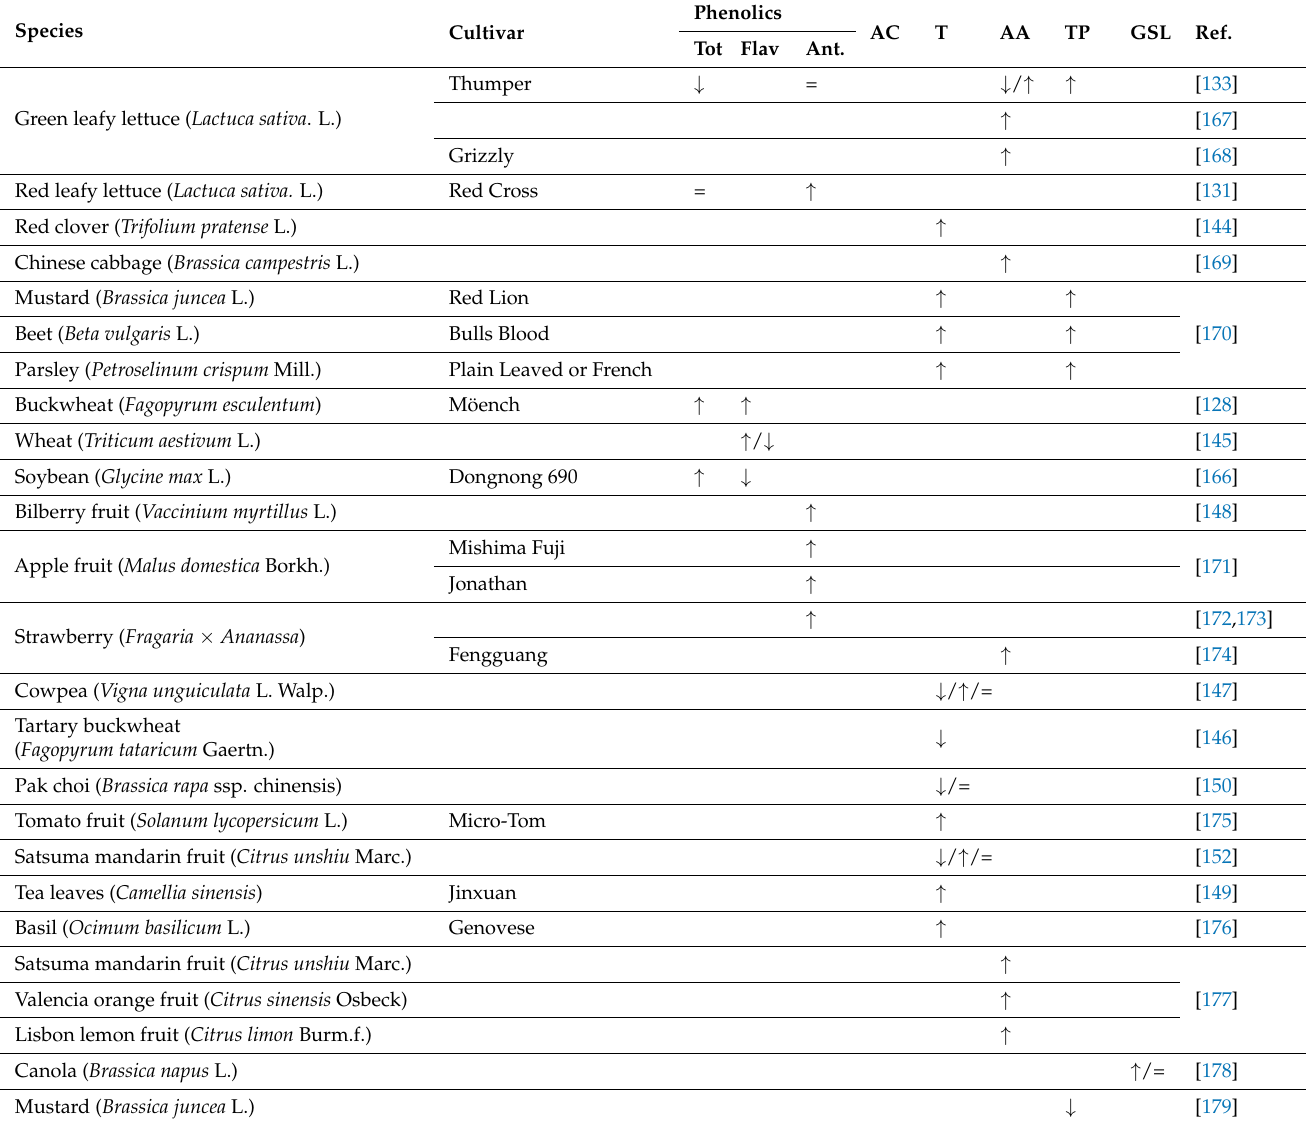
Table 3. Biochemical responses of crops and plants of food interest to blue light wavelengths considered in this review. Tot, total phenolics; Flav, flavonoids; Ant, anthocyanins; AC, antioxidant capacity; T, terpenoids; AA, ascorbic acid; TP, tocopherols; GSL, glucosinolates. For each plant species and cultivar, and for each secondary metabolite or metabolic class considered, the symbols “ ↓ ”, “ ↑ ” and “=” mean a decrease, increase or no variations, respectively, compared to the control plants of each study. Phenolics Species Cultivar AC T AA TP GSL Ref. Tot Flav